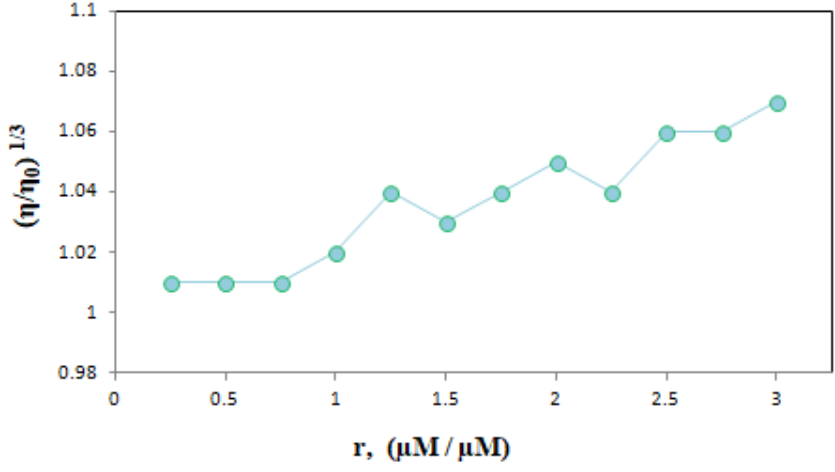
Figure 10. The effect of increasing amount of ELT on the relative viscosity of dsDNA. (r = [ELT] / [dsDNA] = 0.25–3.0).